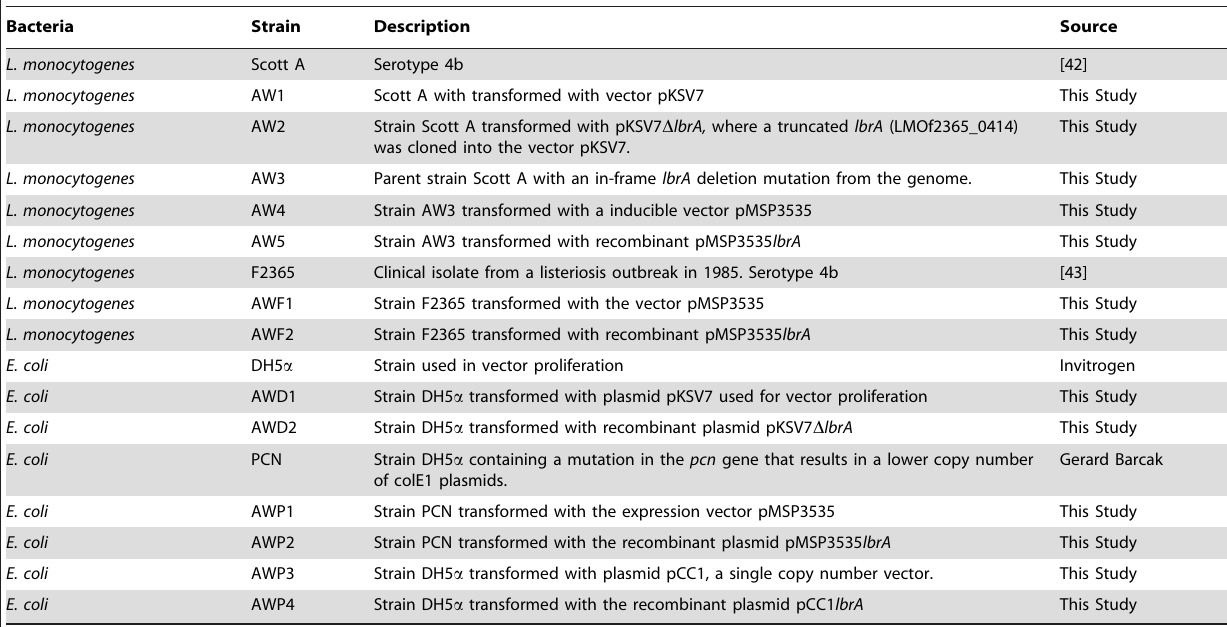
Plasmid Description pKSV7 pKSV7 D